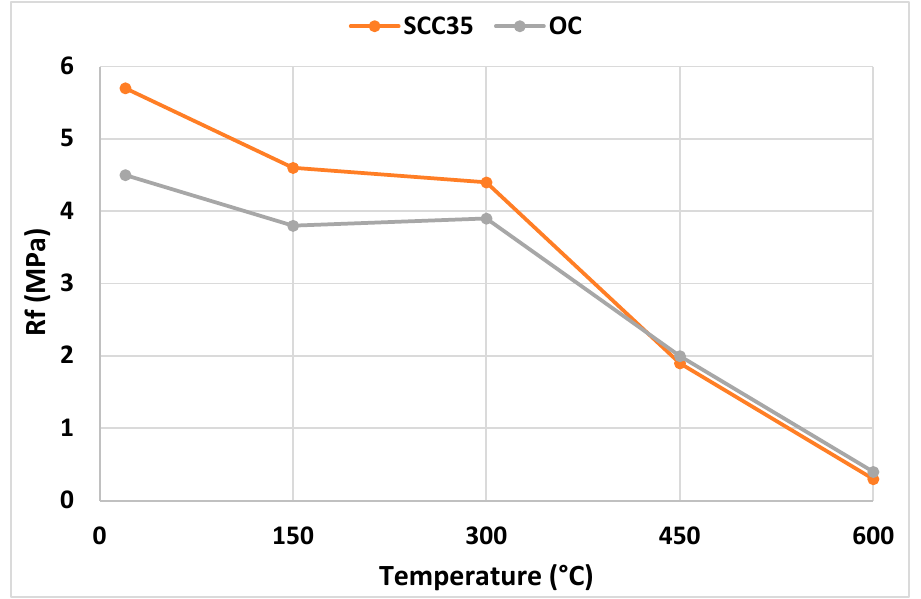
Figure 11. Effect ofthe heating-cooling cycle on the flexural strength.